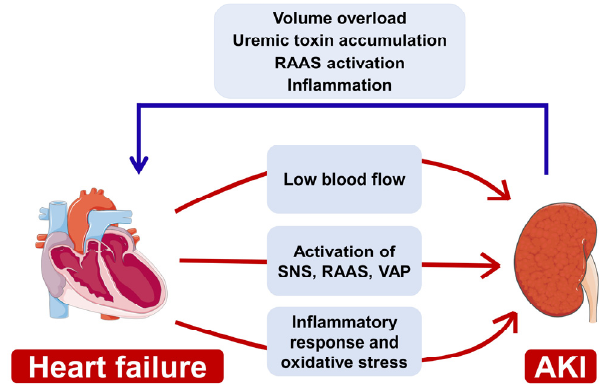
Figure 3. Overview of key kidney–heart interactions. Three major mechanisms contribute to the development or acceleration of cardio-renal dysfunction, including low renal afferent blood flow, activation of SNS, RAAS, VAP, systematic inflammation, and oxidative stress. On the other hand, AKI-induced volume overload, uremic toxin retention, and RAAS over-activation accelerate heart failure. Abbreviations: SNS, sympathetic nervous system; RAAS, renin–angiotensin–aldosterone system; VAP vasopressin.